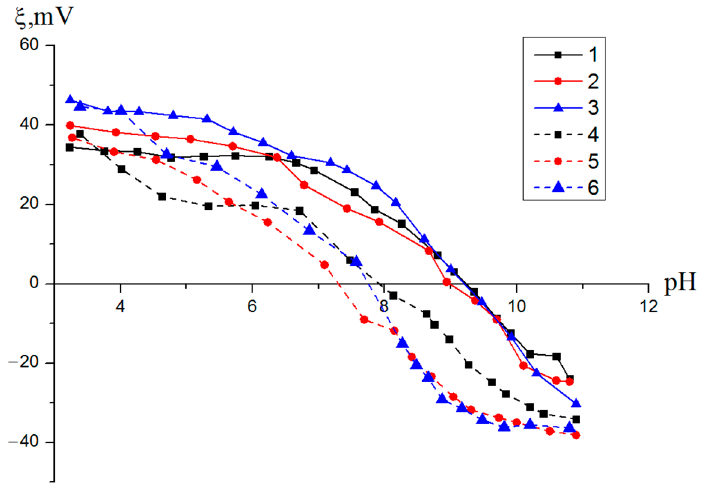
Figure 14. Dependences of the ζ -potential of the nanoscale structures on the pH value for samples 1–6. The antibacterial activity of the nanoscale structures was determined against Gram- negative ( E. coli ) and Gram-positive ( S. aureus , MRSA) bacteria using a broth microdilution assay. MIC values for the nanoscale structures are shown in Table 2. Table 2. The MIC values (mg × mL − 1 ) of the nanostructures against E. coli , S. aureus and MRSA. Strain